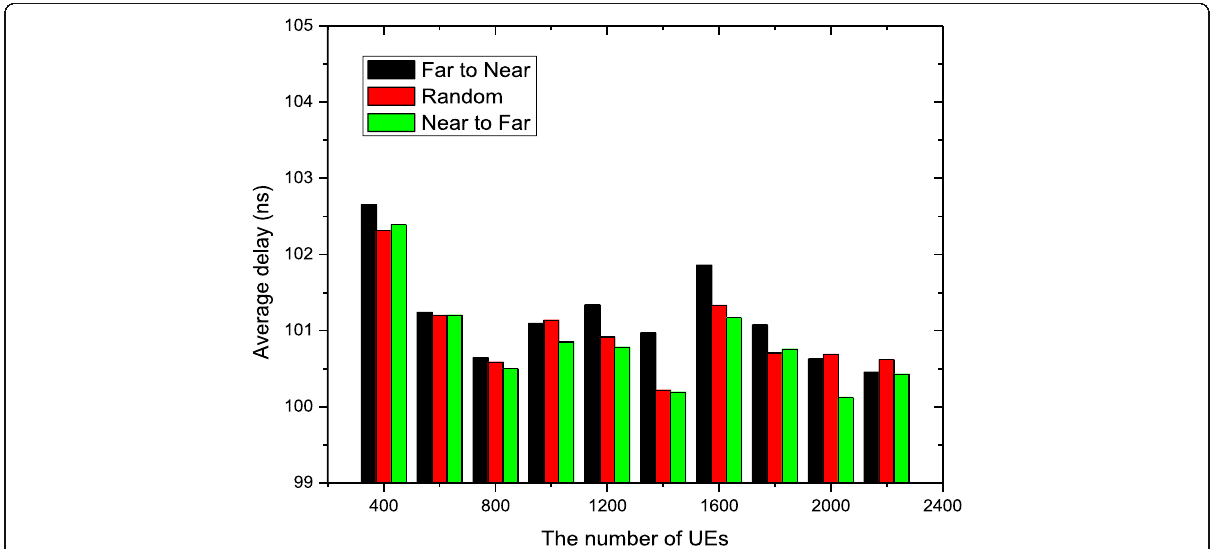
Fig. 17 Average delay for the DTO-MROD scheme under the different verification orders of relay